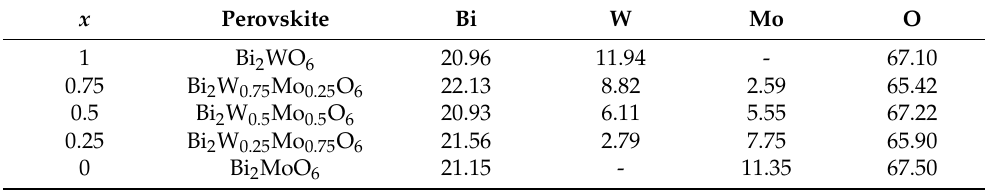
Table 3. Elemental composition of layered perovskites Bi 2 W x Mo 1 − x O 6 (at%) obtained from EDS. x Perovskite Bi W Mo